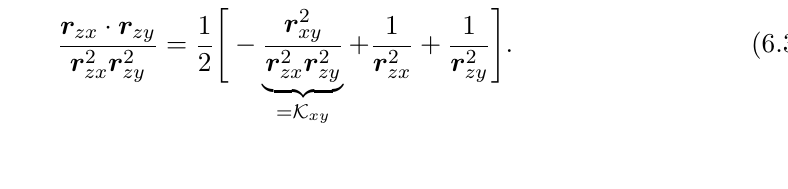
Table 3 . Summary of the slow gluon limit color correlators and